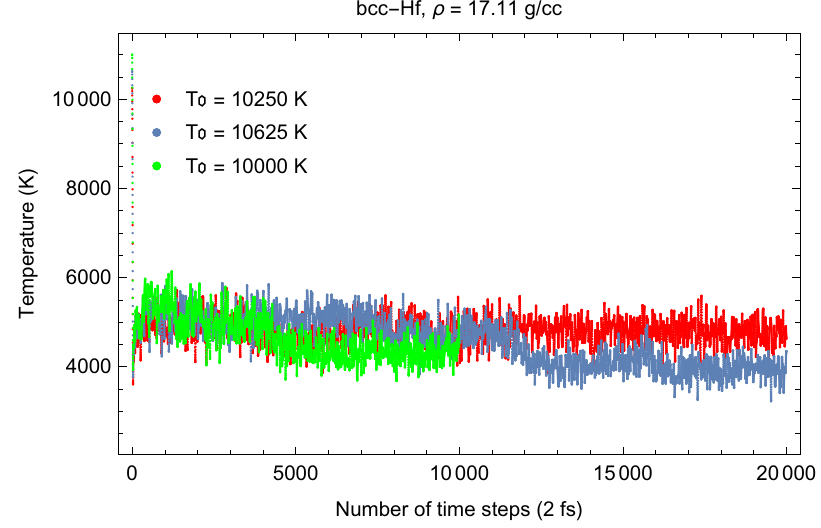
Figure 17. Time evolution of T for bcc-Hf with a density of 17.11 g/cc in three QMD runs with initial T 0 s separated by 375 K.